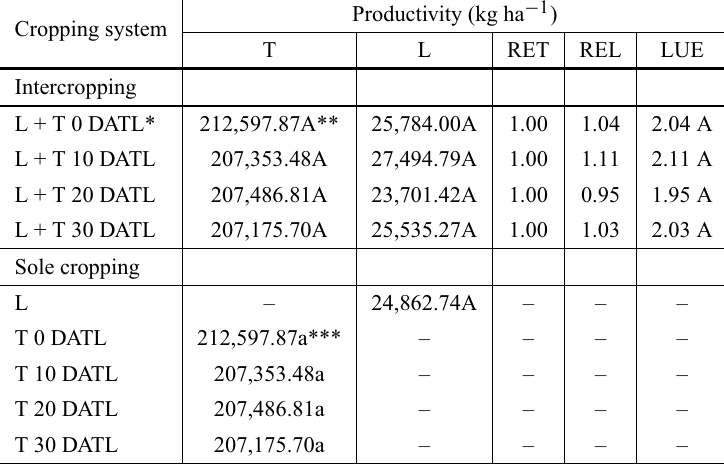
Productivity of lettuce (L) and tomato (T) in intercropping and in sole crop- ping; relative efficiency indices of the crop components of intercropping (RET and REL for tomato and lettuce, respectively) and land use efficiency index (LUE). First cropping season: April 17 to September 9, 2003. Cropping system